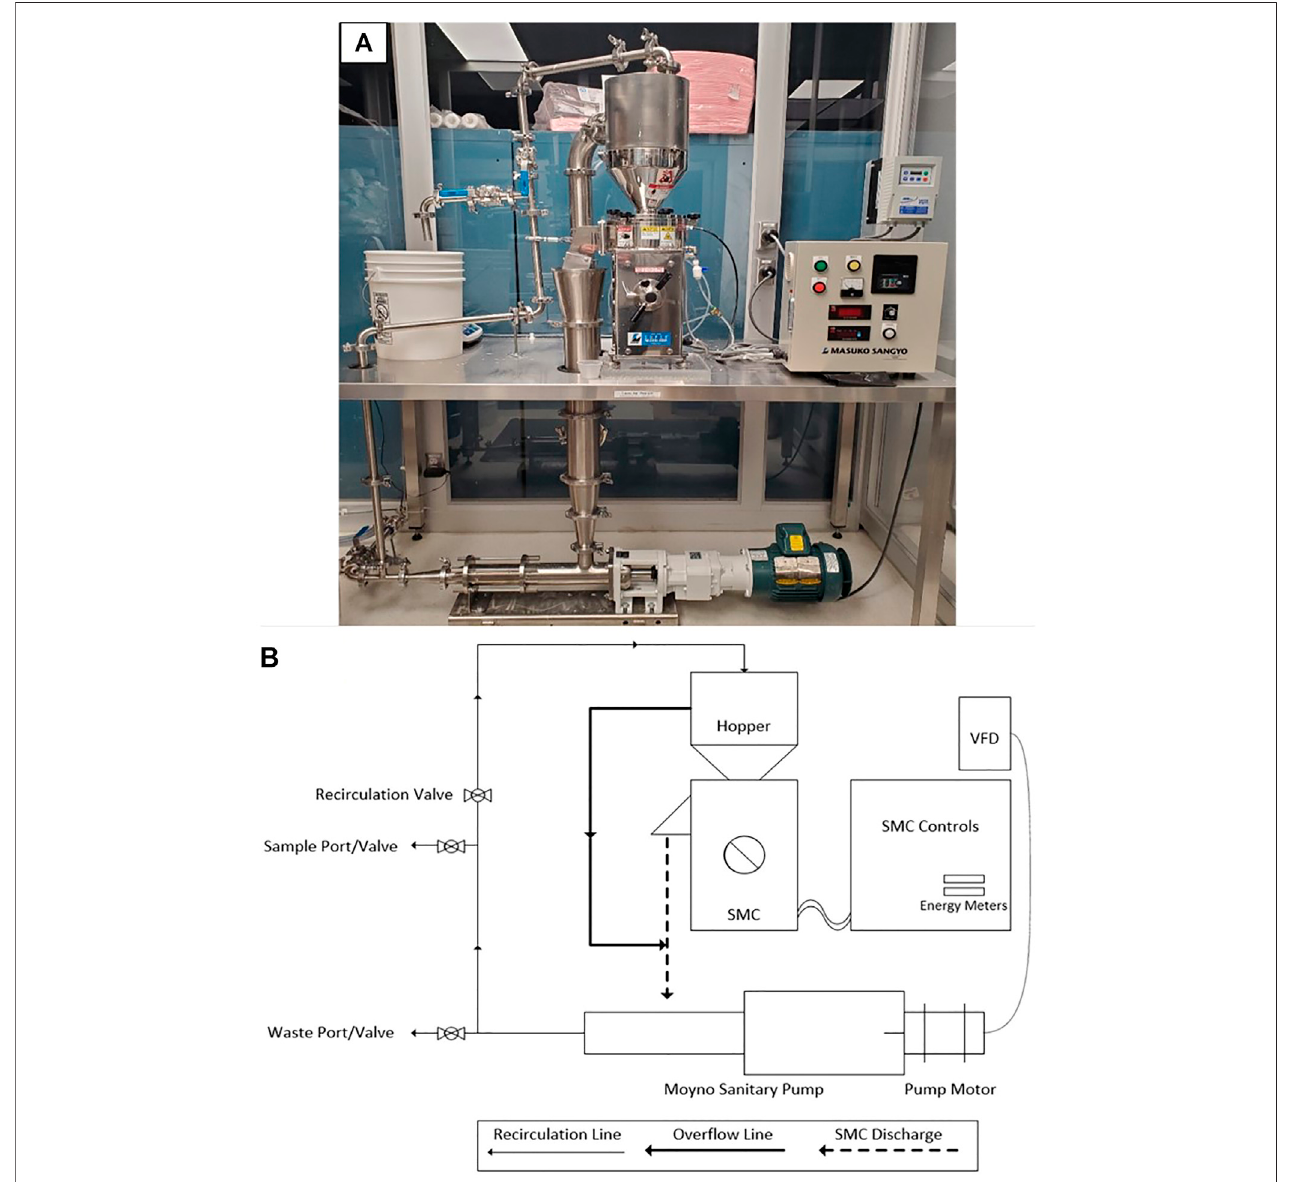
FIGURE 1 | Supermasscolloider Re fi ning System (A) SMC re fi ning system and (B) schematic view.